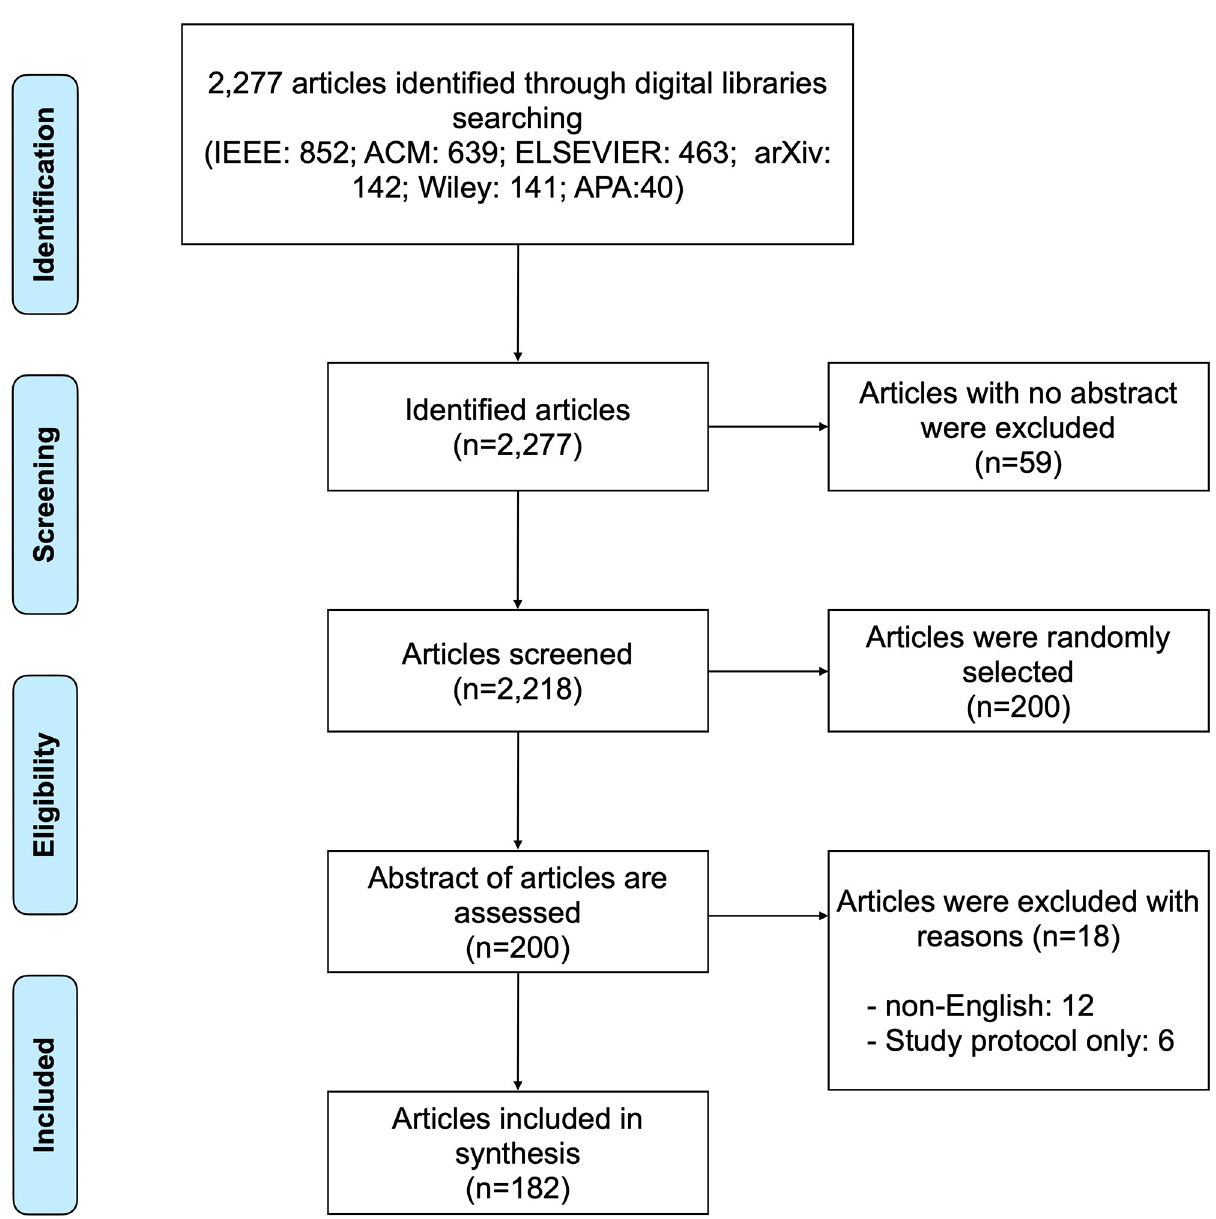
Fig 1. PRISMA flow chart of literature search for fake news from 2010 to 2020.